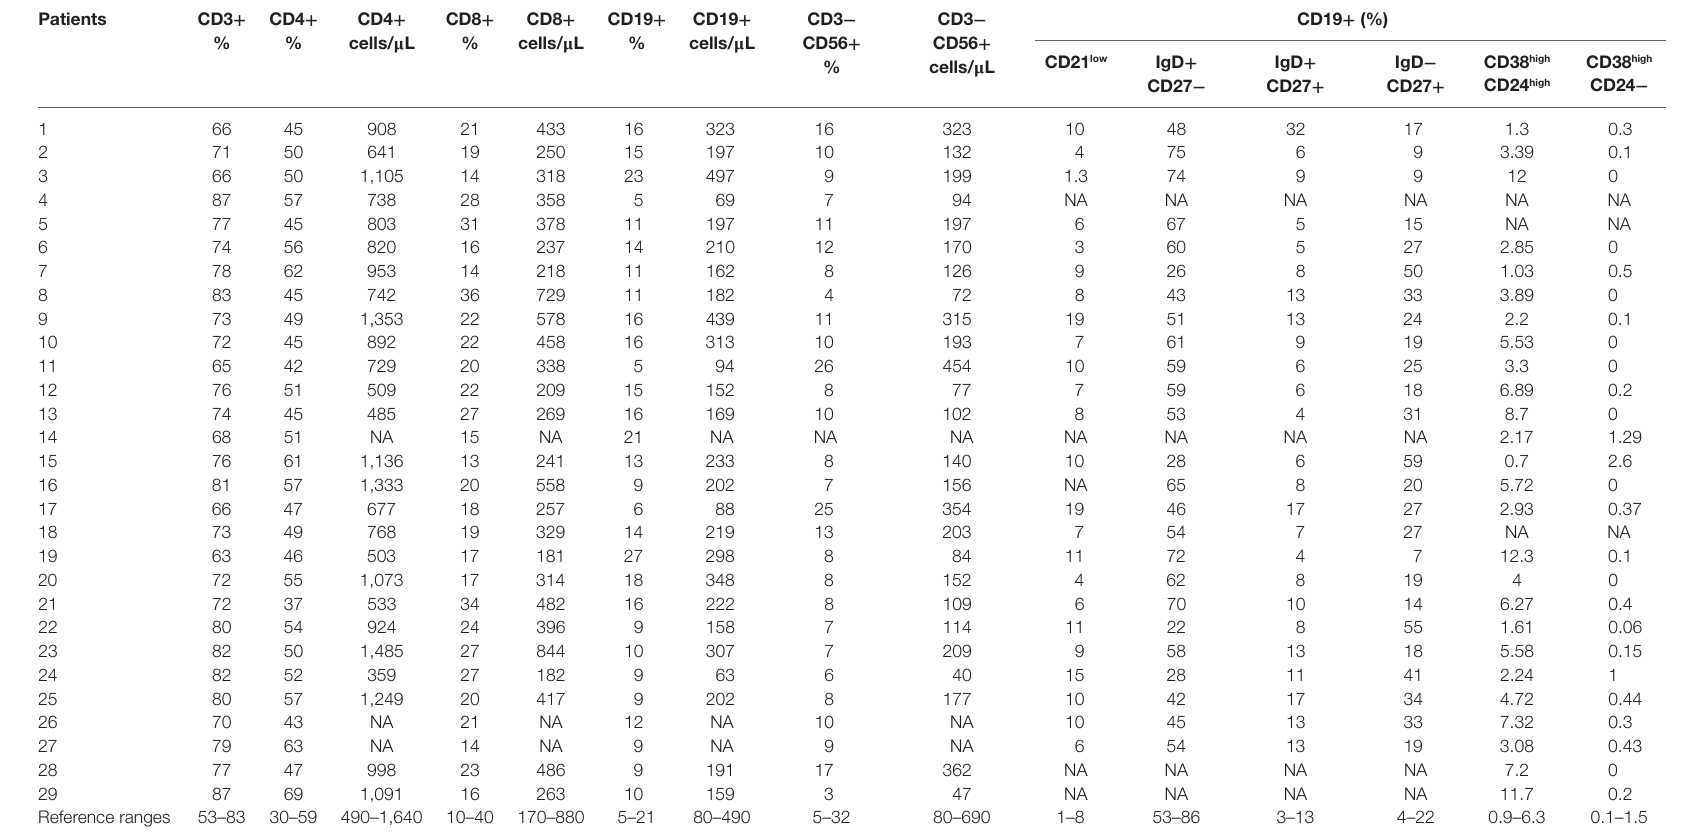
TaBle 1 | Lymphocytes subpopulations of untreated multiple sclerosis (MS) patients.